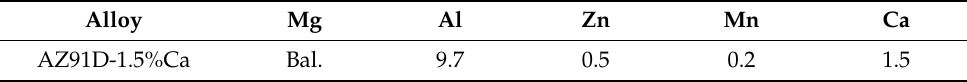
Table 1. Chemical composition of AZ91D-1.5% Ca alloy (wt.%).